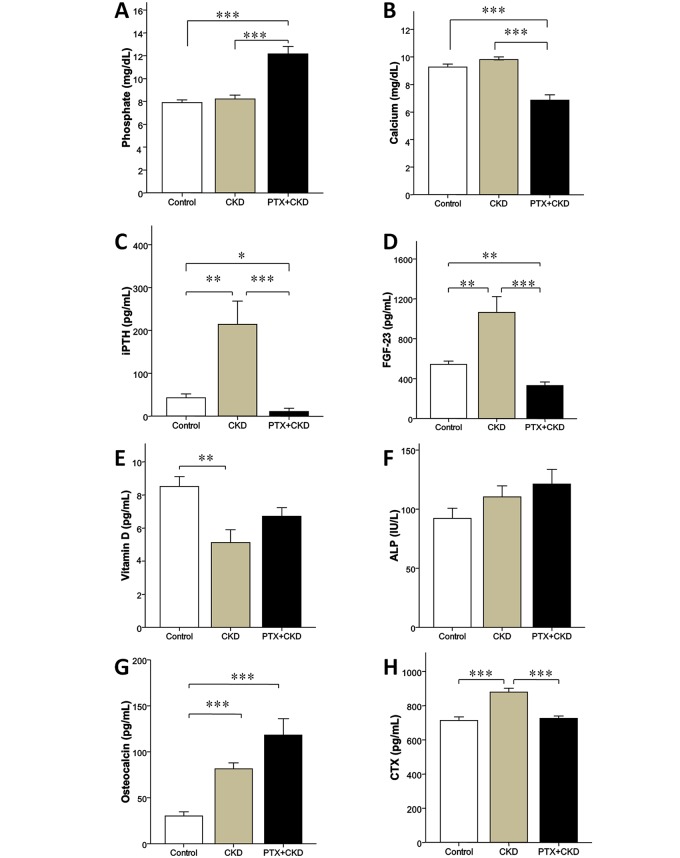
Comparison of serum biochemical parameters between control CKD and PTX +CKD group.(A) Serum phosphate levels. (B) Serum calcium levels. (C) Serum intact PTH levels. (D) Serum FGF-23 levels. (E) Serum Vitamin D (1,25-(OH)2D3) levels. (F) Serum ALP levels. (G) Serum osteocalcin levels. (H) Serum CTX levels. n = 8 control, n = 9 CKD, n = 9 PTX +CKD. Results were presented as mean ± SEM. * p < 0.05, ** p < 0.01, *** p < 0.001.